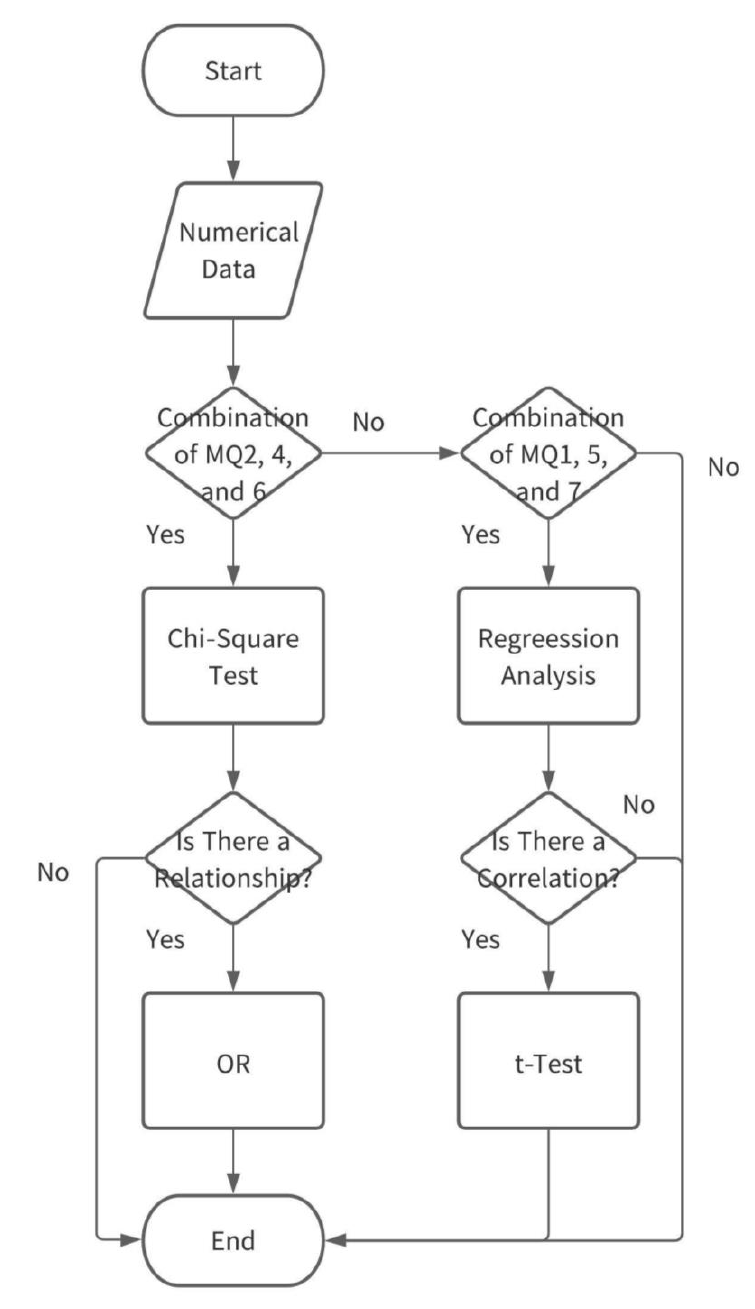
Figure 1. Flowchart of statistical analysis.